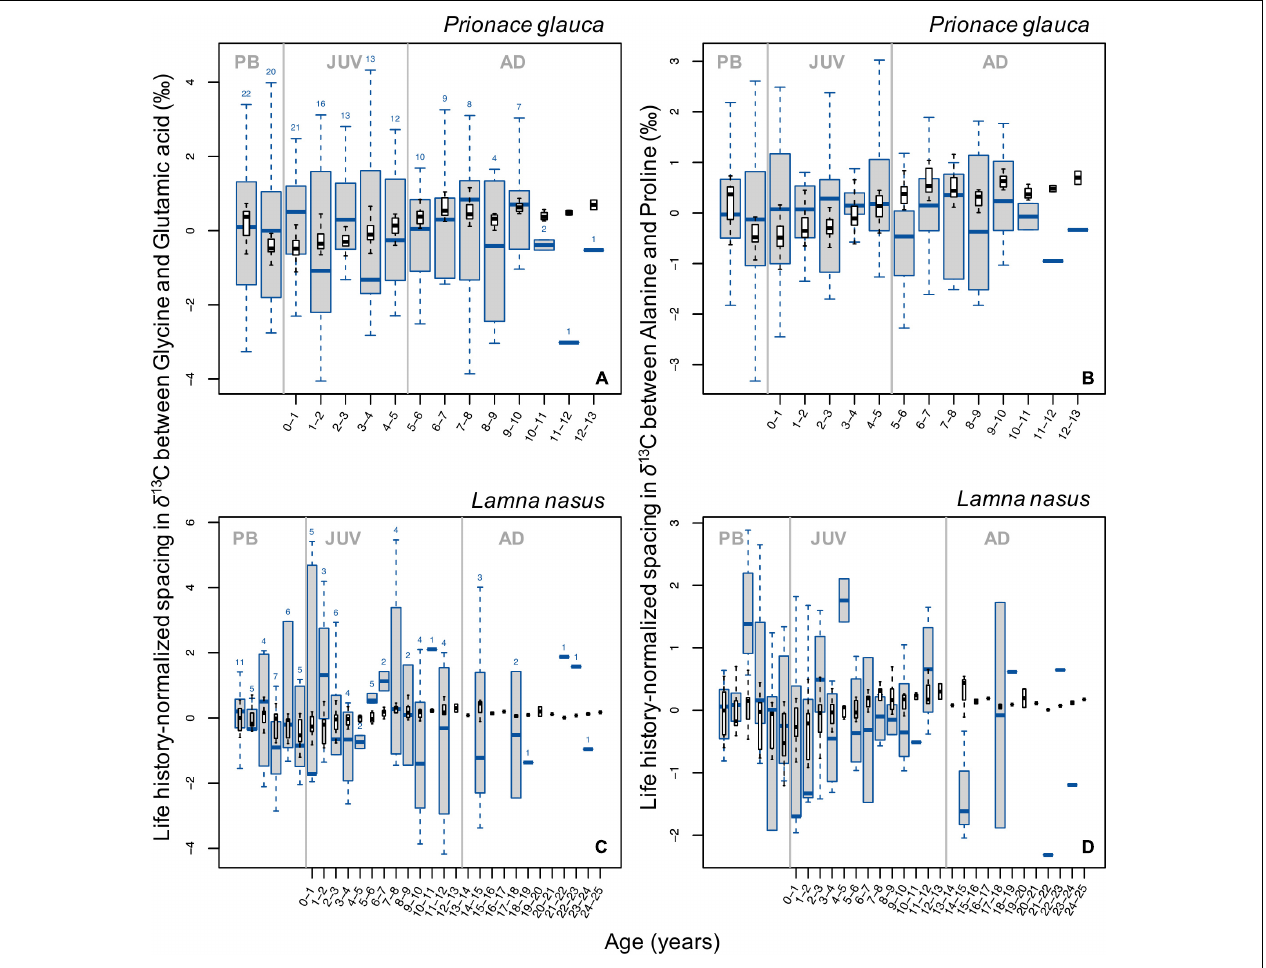
FIGURE 6 | Boxplots (in blue) of life history-normalized spacing in δ 13 C values between independent pairs of glycolytic (lipid-derived) and Krebs cycle (lipid+protein-derived) amino acids ( A,C, glycine and glutamic acid; B,D alanine and proline) by age class in blue sharks (A,B) and porbeagles (C,D) . Boxplots (in black) of life history-normalized δ 13 C values of bulk protein are overlain for comparison. Figure description is the same as for Figure 2